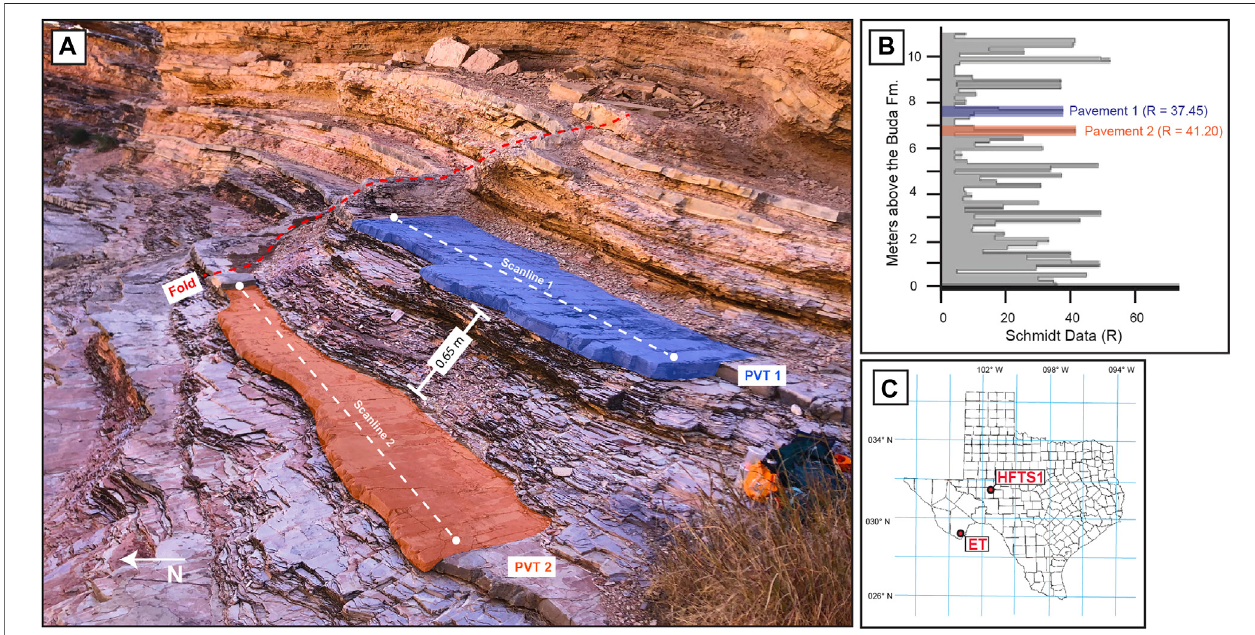
FIGURE 7 | (A) Field photograph showing Pavement 1 highlighted in blue, and 0.65 m stratigraphically below, Pavement 2 highlighted in orange. A fold bounds their eastern edge; the trace of the fold axial plane is denoted with a red dashed line. The locations of Scanline 1 and Scanline 2 are shown with white dashed lines. (B) Schmidt hammer rebound pro fi le for the bottom 10 m of the Ernst member modi fi ed from McGinnis et al. (2016; their Figure 5 ). Pavement 1 is highlighted in blue and Pavement 2 is highlighted in orange. It can be noted that both pavements have a signi fi cantly higher rebound value than the beds immediately adjacent. This rebound value (R) is a good indicator of mechanical stratigraphy present at Ernst Tinaja. (C) Map of Texas and the surrounding area, with the HFTS1 location labeled in West-Central Texas, and the Ernst Tinaja location labeled to the south near the Mexico border in West Texas.